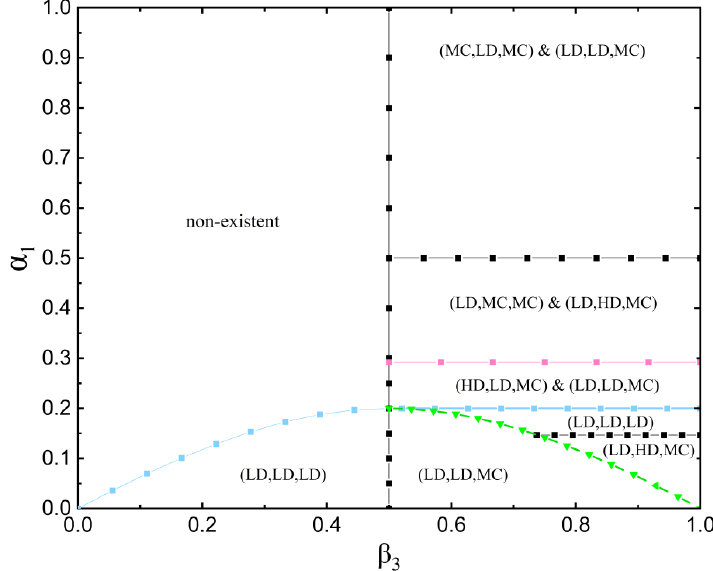
Figure 10. System phase diagram when n is fixed at 0.5.